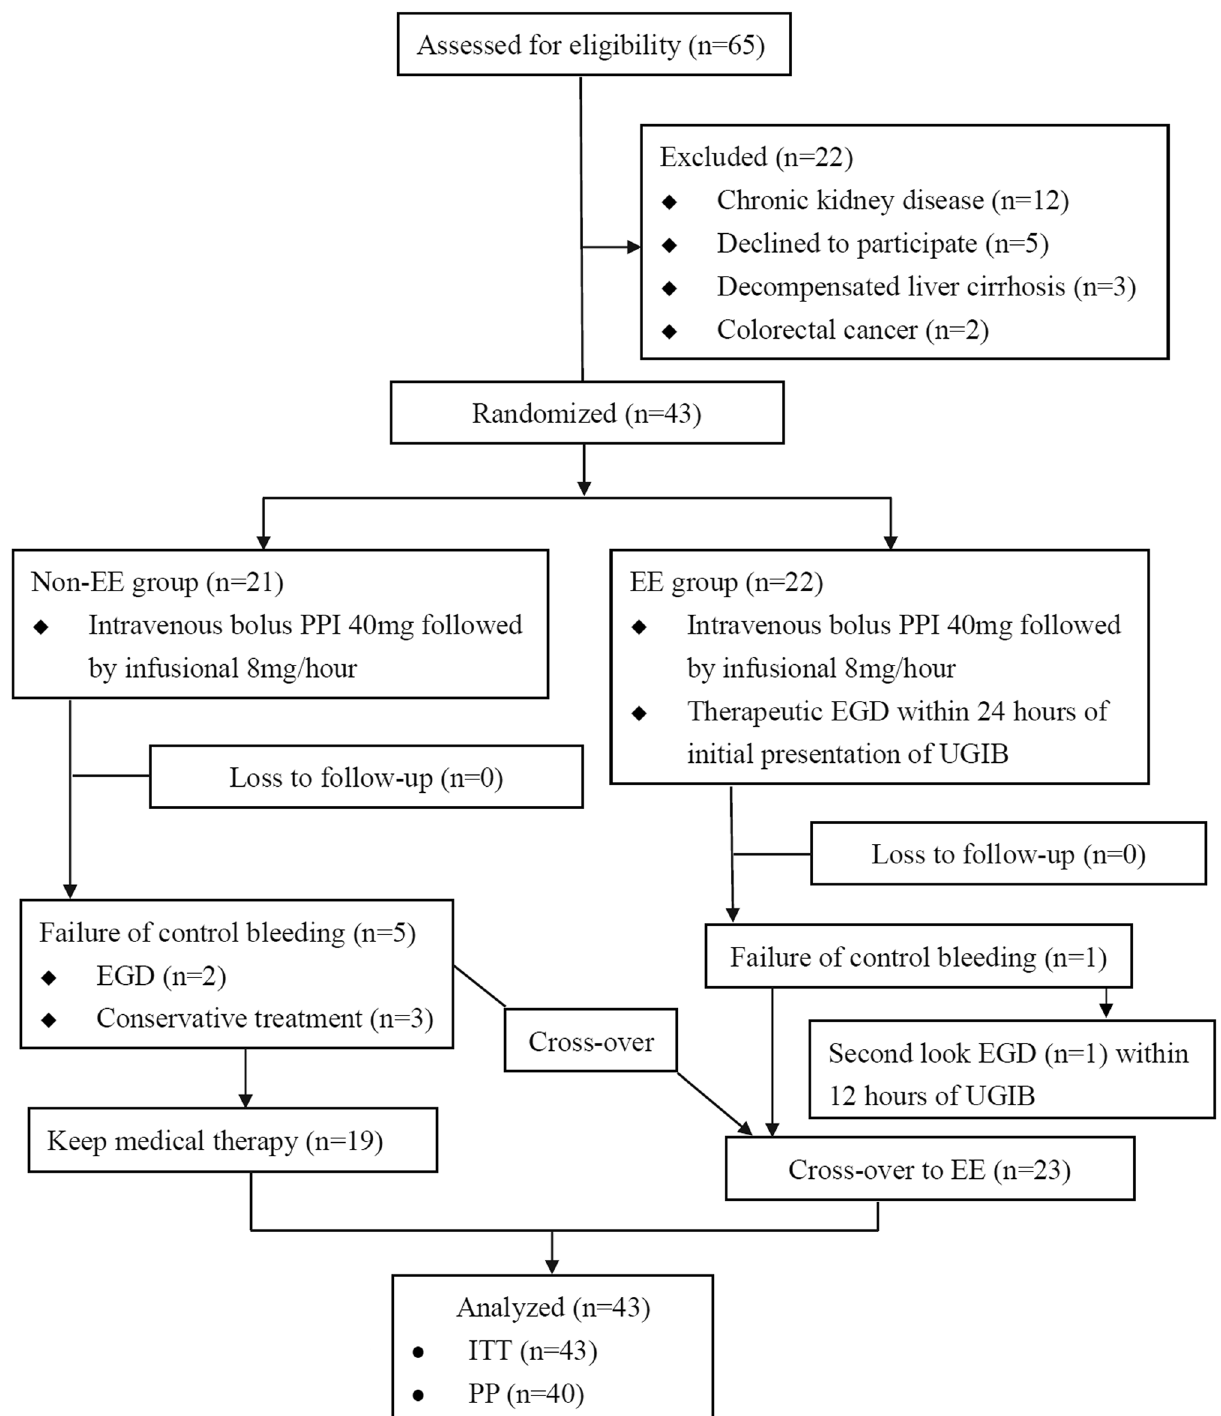
Figure 1. Flow algorithm for enrollment. EE emergent endoscopy, EGD esophagogastroduodenoscopy, ITT intention-to-treat, PP per-protocol, PPI proton pump inhibitor, UGIB upper gastrointestinal